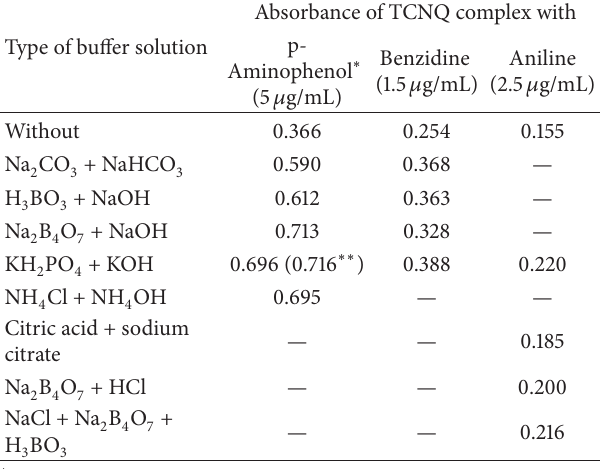
Table 1: Effect of buffer solutions on the absorbance of aromatic amine-TCNQ